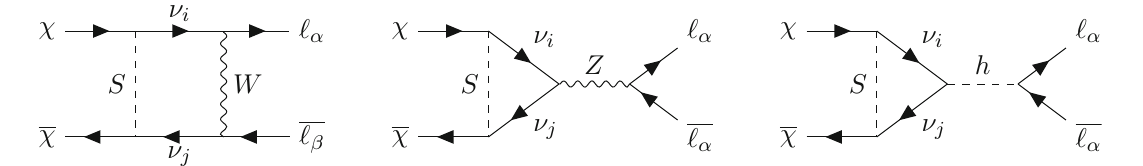
Fig. 3 One-loop diagrams (in unitary gauge) contributing to annihilation of DM into charged lepton-antilepton pairs (cid:6) α (cid:6) β , α,β = e ,μ,τ . The indices i and j run from 1 to